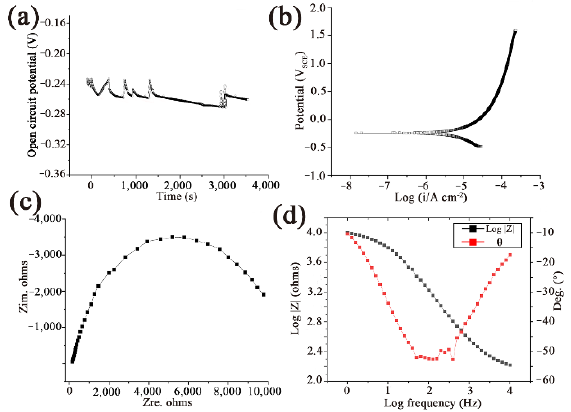
Figure 4. ( a ) The curve of corrosion open circuit potential with time; ( b ) Potentiodynamic polarization curve; ( c ) Electrochemical impedance spectroscopy; ( d ) Bode plot (black) and phase angle (red) curve.